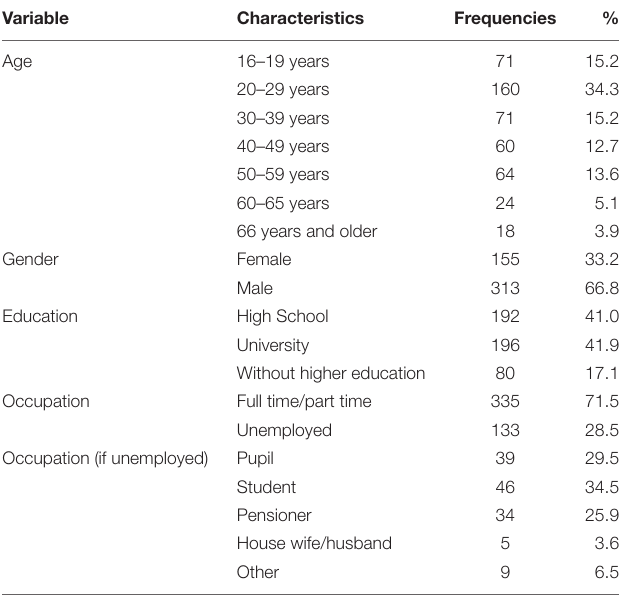
TABLE 2 | Demographic profile of the